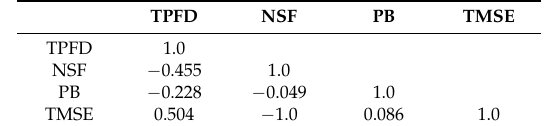
Table 3. Correlation coefficient of representative pairs of model accuracy indicators (MAIs) in Table 1.